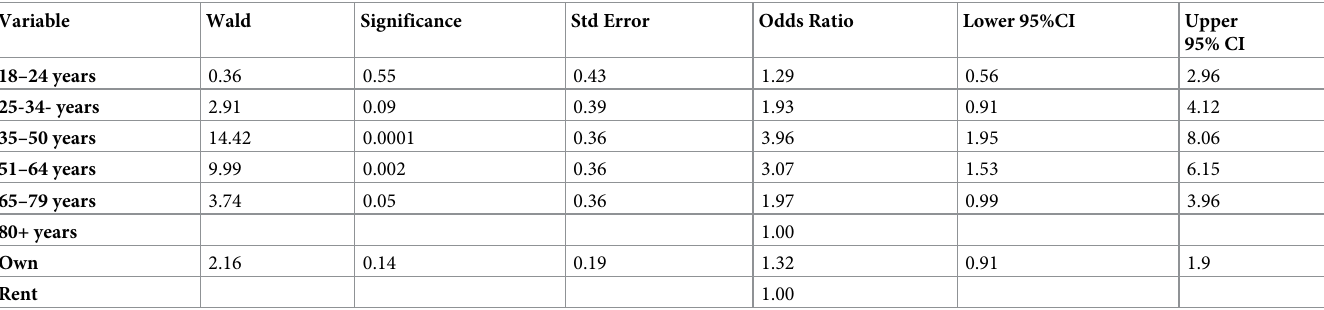
Table 2. Regression analysis results (those affected by flooding in